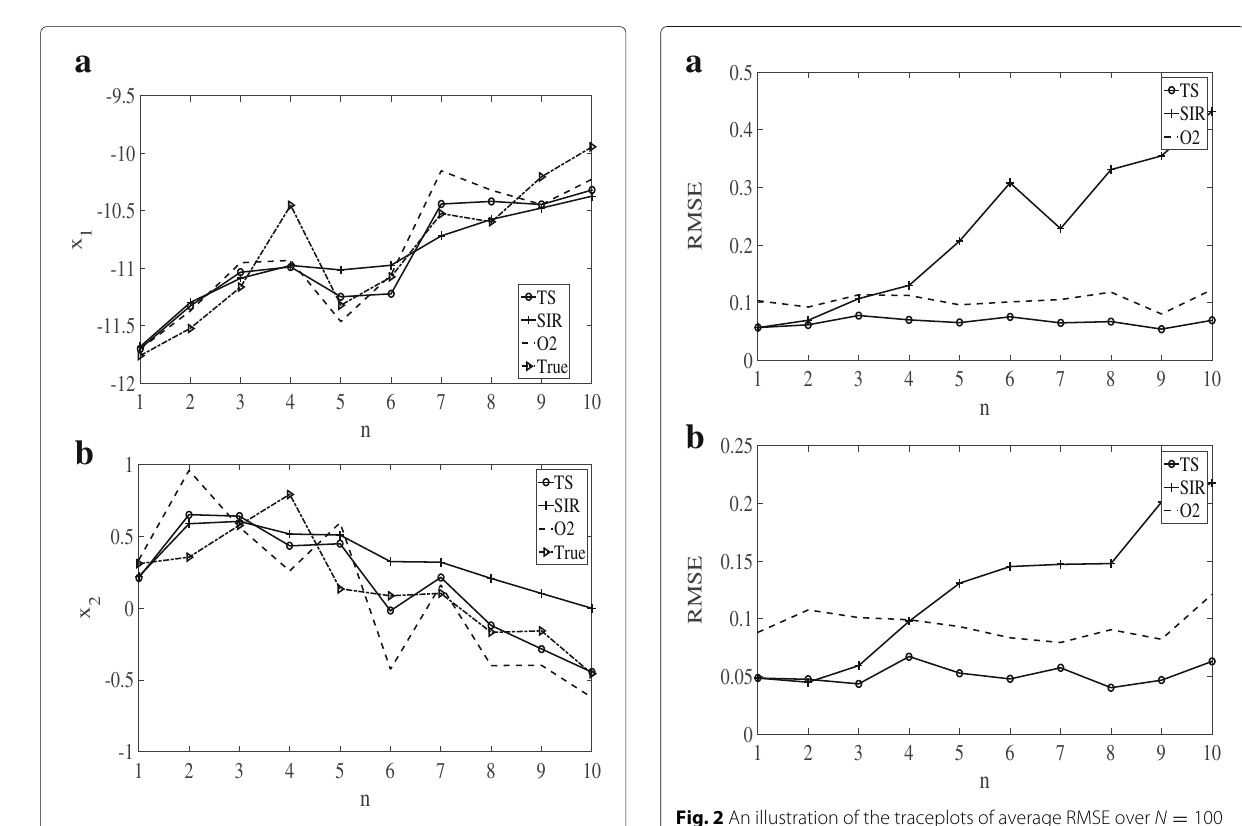
Fig. 1 An illustration of the trajectories of the true state space variables and their estimates based on the SIR, TS, and O 2 procedures for Example 1. The trajectories are obtained for one experiment based ( Q , R ) = ( 0.2,0.1 ) : ( a ) x n ,1 and ( b ) x n ,2